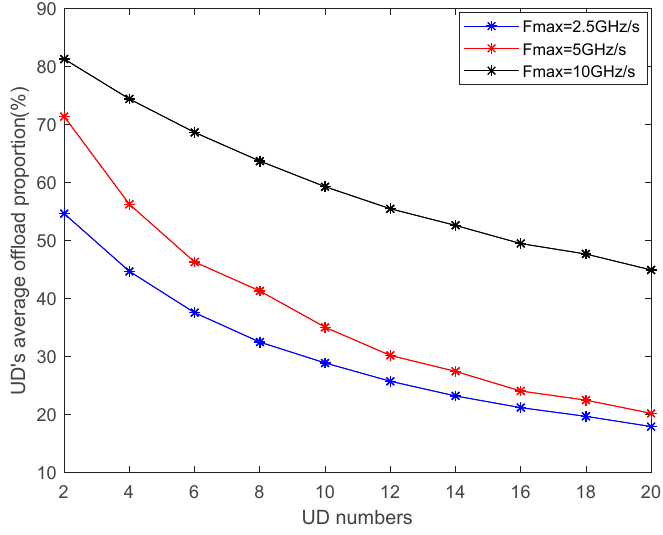
Figure 10. UD's average offload proportion varies with UD numbers. Figure 10. UD’s average o ffl oad proportion varies with UD